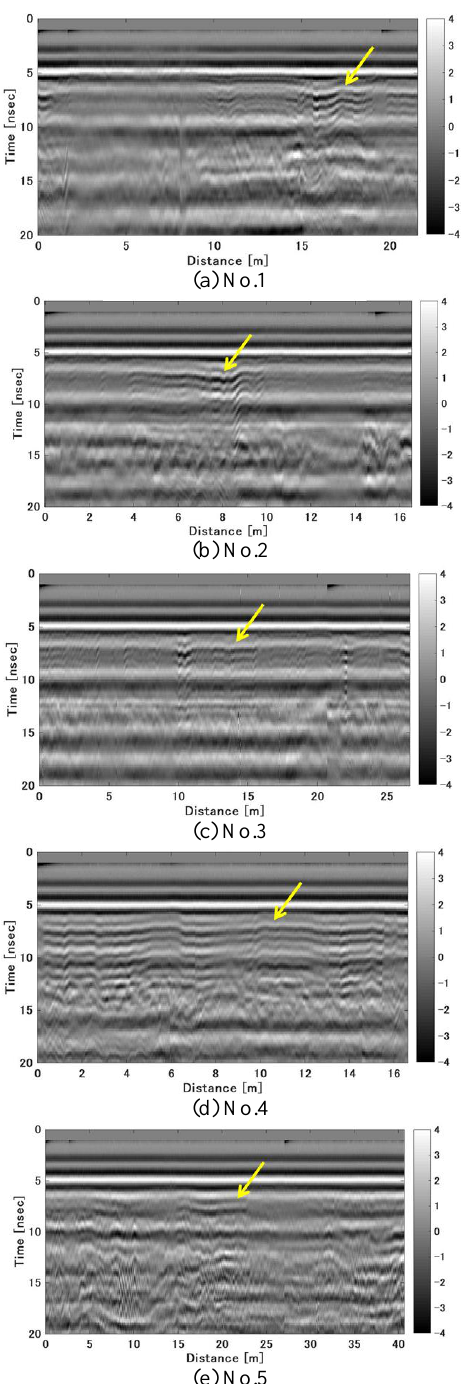
Figure 8. Bscan image obtained from 600MHz antenna.